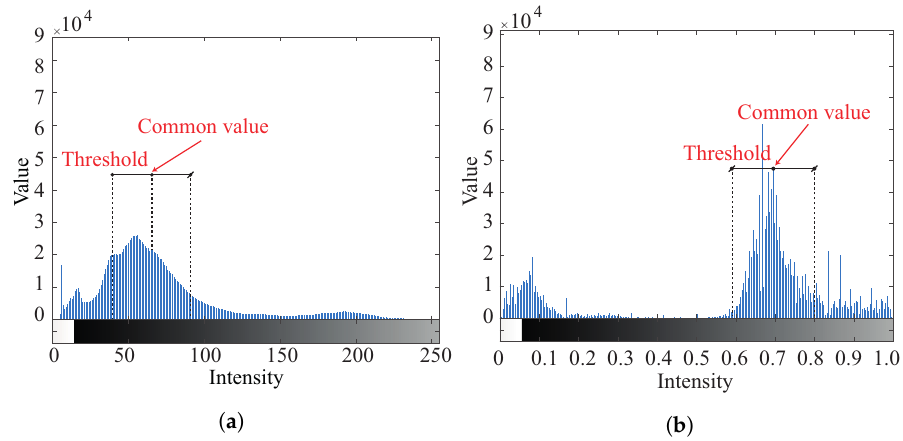
Figure 7. Determination of thresholds for binarization of image. ( a ) Histogram of the gray scale image. ( b ) Histogram of the saturation image.